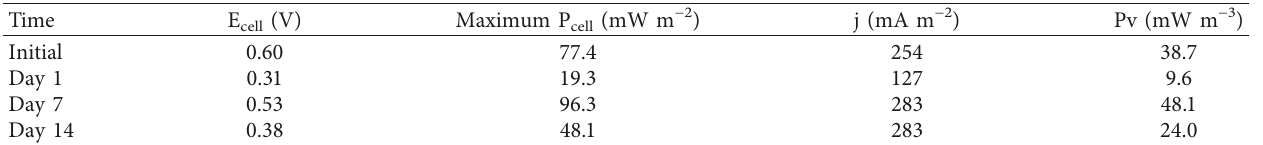
Figure 6: Long-term test of the MFC. Anode chamber: S +AB7-f + B. subtilis bioanode and PWW as substrate (pH � 9.2). Cathode chamber: 20% Pt/C catalysts in KOH (pH � 9.7) electrolyte. Nafion ® 117 alkalinized membrane was used as separator. (a) E cell -j and P cell -j curves obtained at the initial of the test, (b) P cell -j curves obtained during the initial, days 1, 7, and 14, and (c) open circuit voltage of the MFC vs. time using a R ext � 10k Ω . Table 2: Electrochemical parameters of the MFC during the long-term